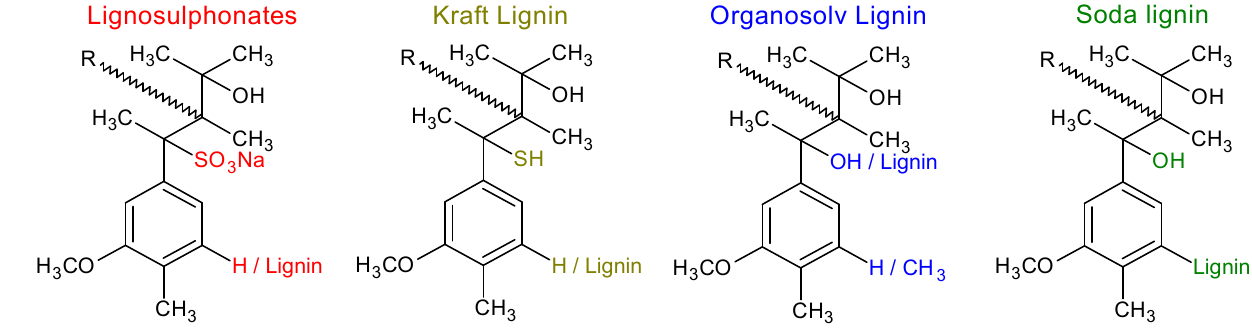
Figure 4. Predicted changes in the structure of lignin after delignification. Analyses of lignin properties are therefore a must-do before any prediction about its further use or direct application. The right selection of methods might facilitate the interpretation of results, whereas wrong or very generic methods might decrease the accuracy and make it difficult to interpret results. One of the examples is phenolic hydroxyl group content where the results vary depending on the method used